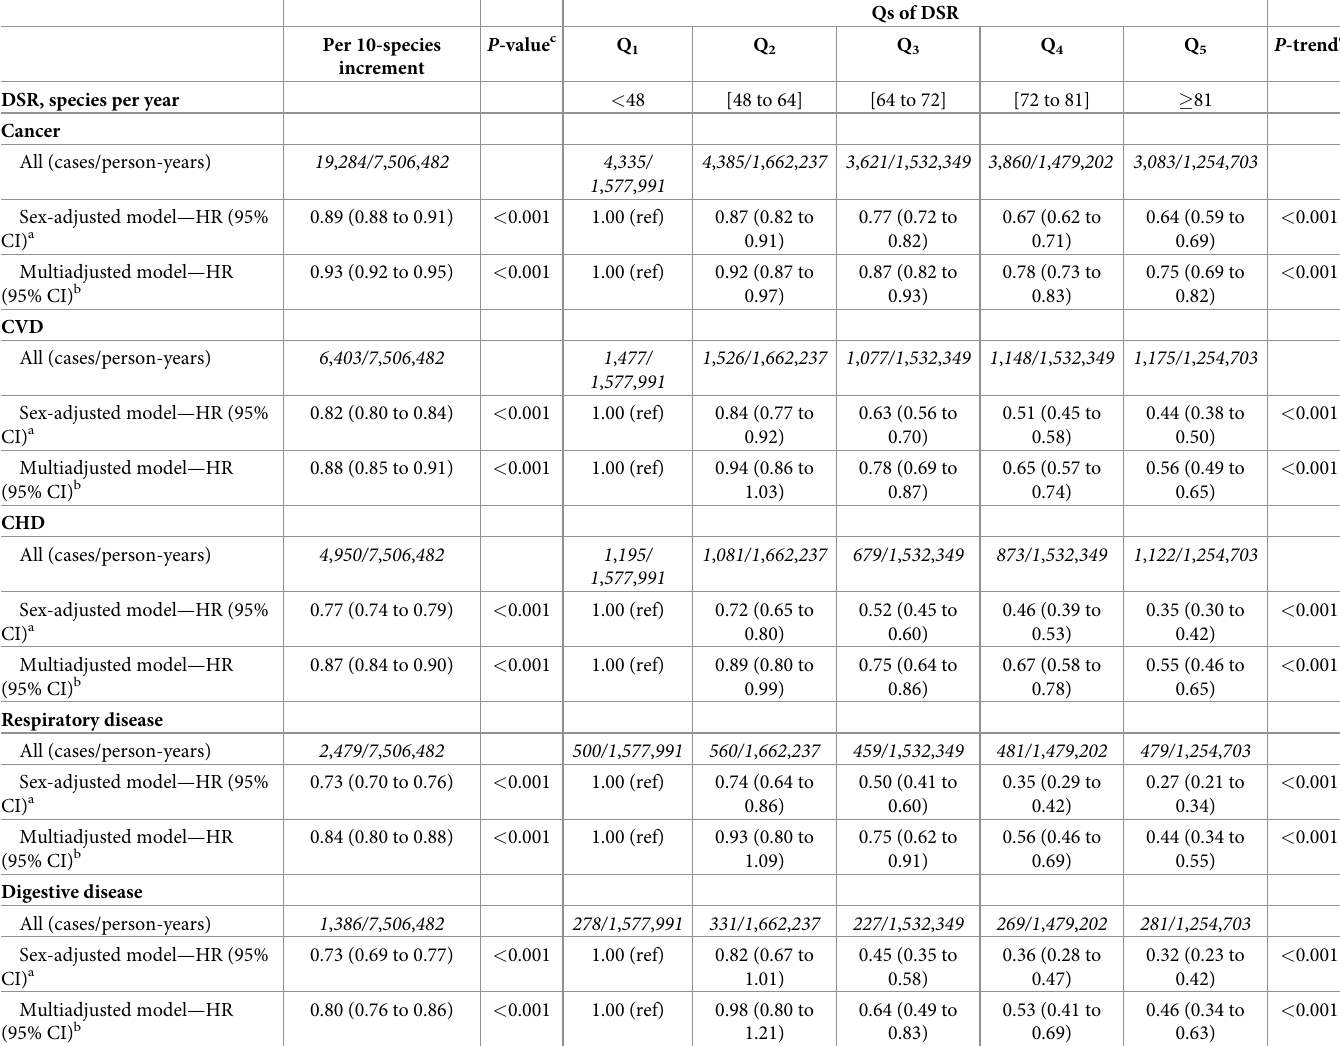
Table 2. Associations between food biodiversity and cause-specific mortality rates from multivariable Cox proportional hazards regression models, EPIC cohort, 1992 to